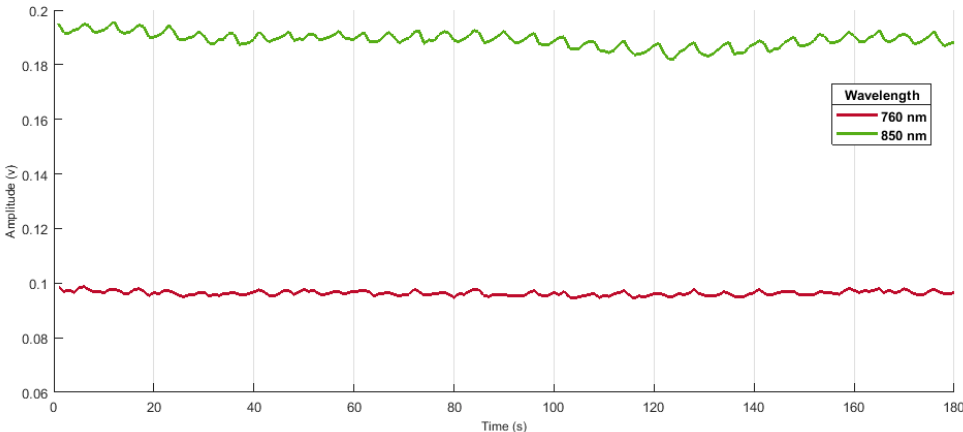
Figure 11. The fNIRS data obtained from a healthy subject according to the experimental protocol. The upper signal is from the source of 760 nm, and the lower one represents the 850 nm wavelength.